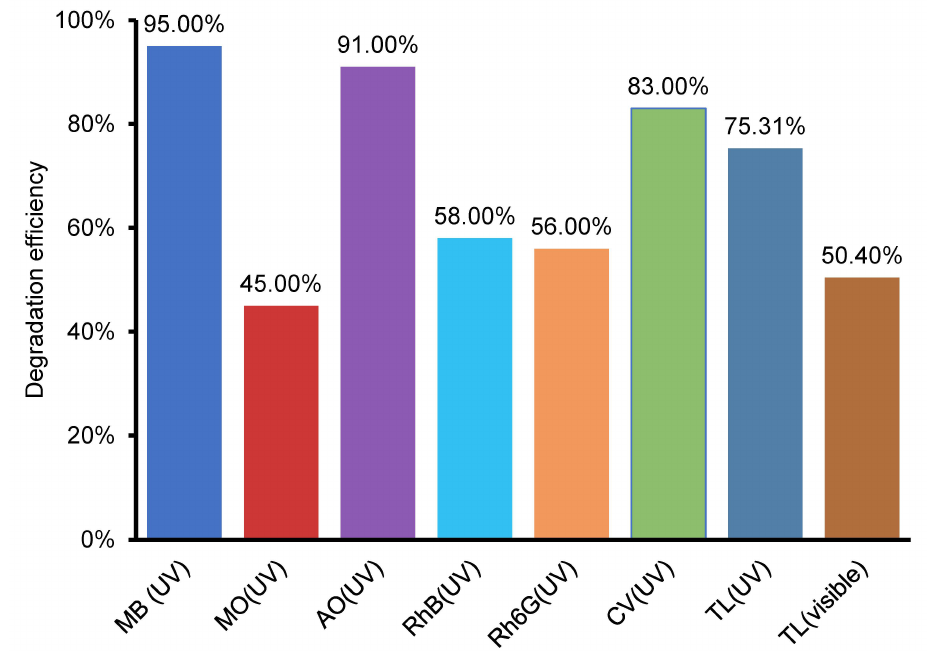
Figure 13. Significant degradation efficiency of all dyes and